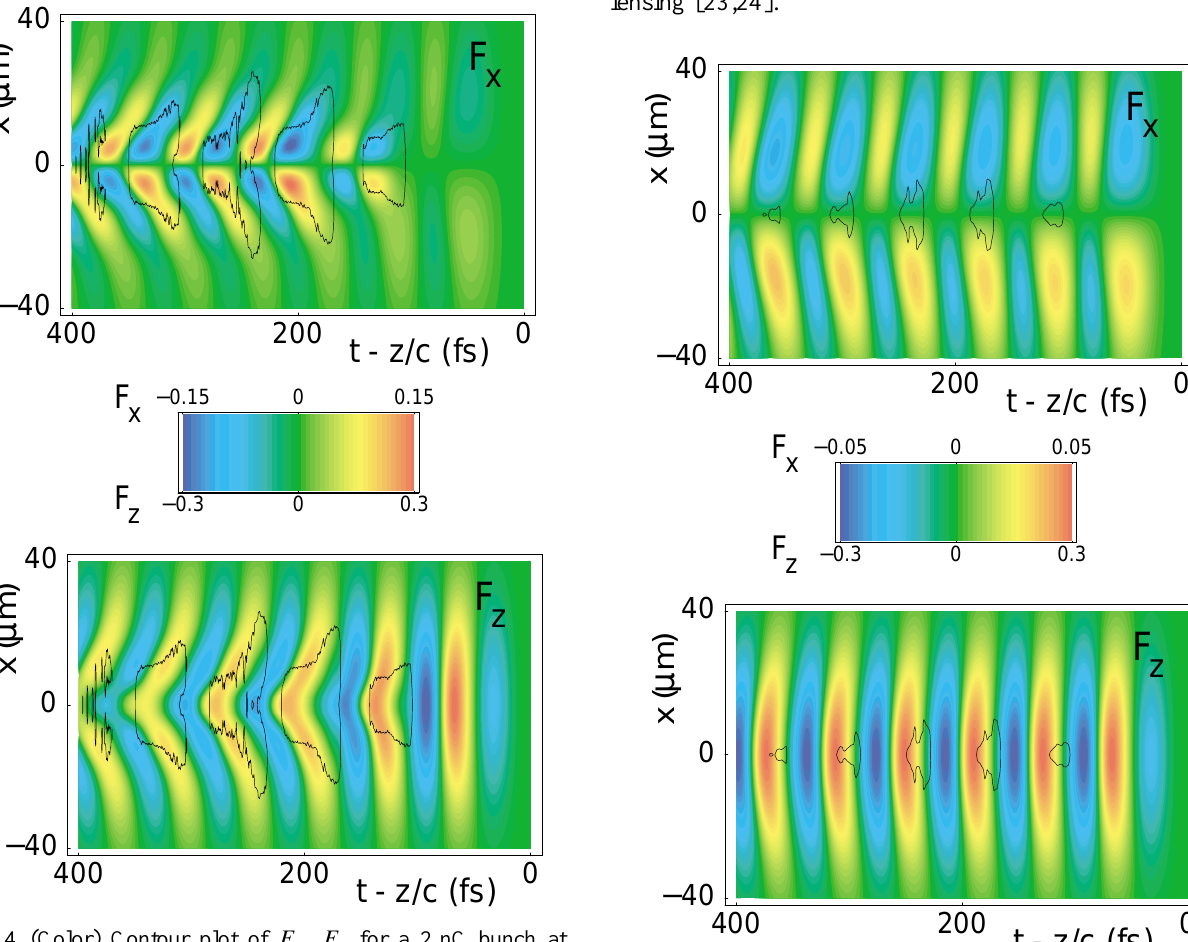
FIG. 4. (Color) Contour plot of F x , F z for a 2 nC bunch at 2 mm propagation distance. Bunch electron density contours are shown in black. FIG. 5. (Color) As in Fig. 4 for test particle